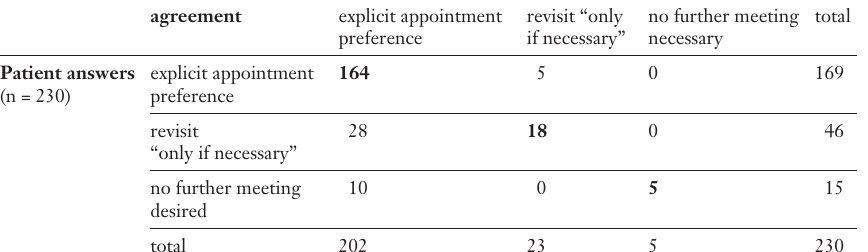
The modified Bland- Altman plot shows the log ratio of patient-to-physician revisit interval esti- mates against the average of the as- signments